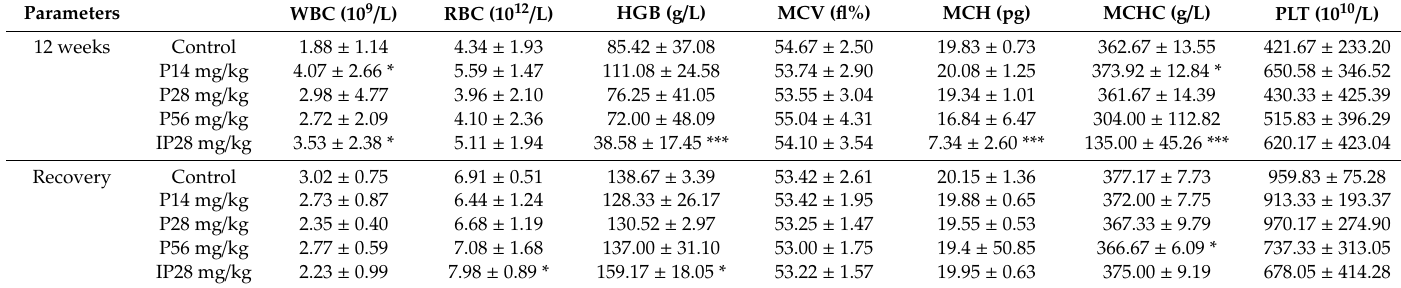
Table 3. Hematological values of rats after 3 months of repeated administration and 2 weeks of recovery, respectively (mean ± SD, n = 12 for administration and n = 6 for